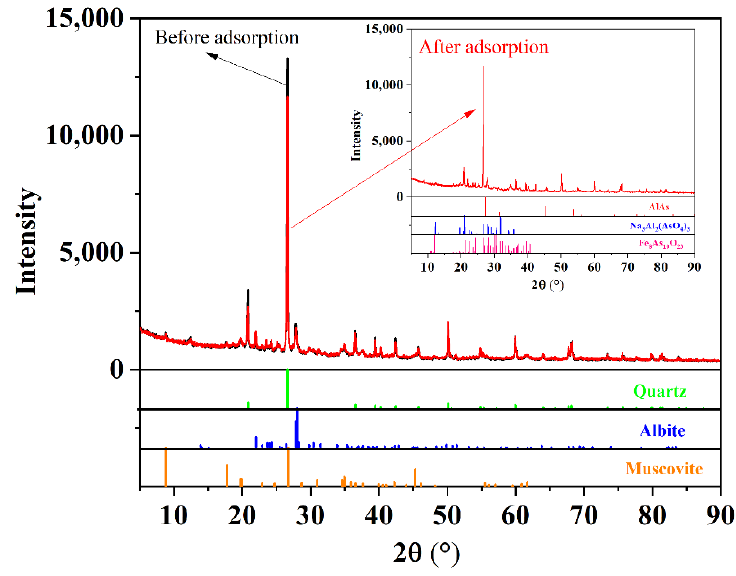
Figure 5. XRD patterns and the mineral compositions analysis of sediment samples before and after MTAs V adsorption.